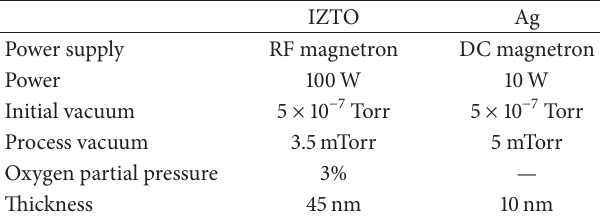
Table 2: Process